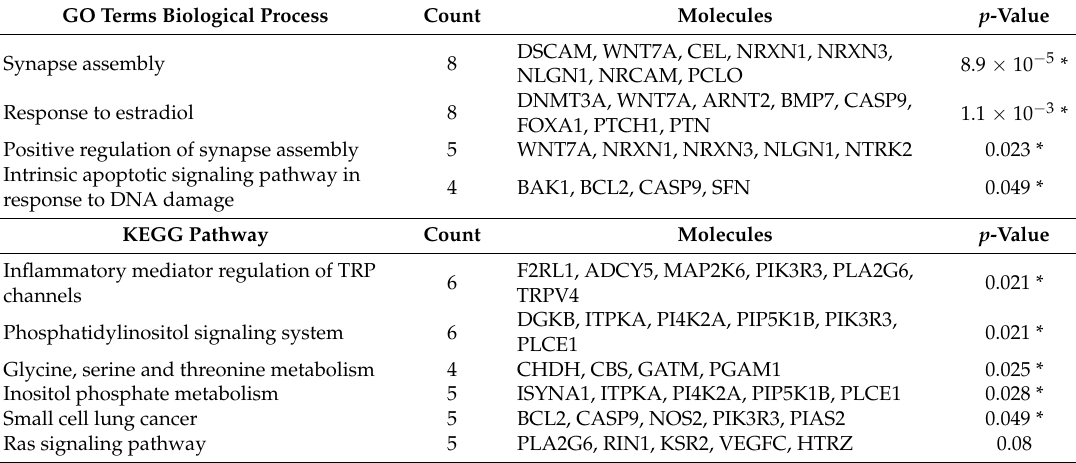
Table 4. GO term biological process enrichment results and significantly altered pathways in CSMD1 signature